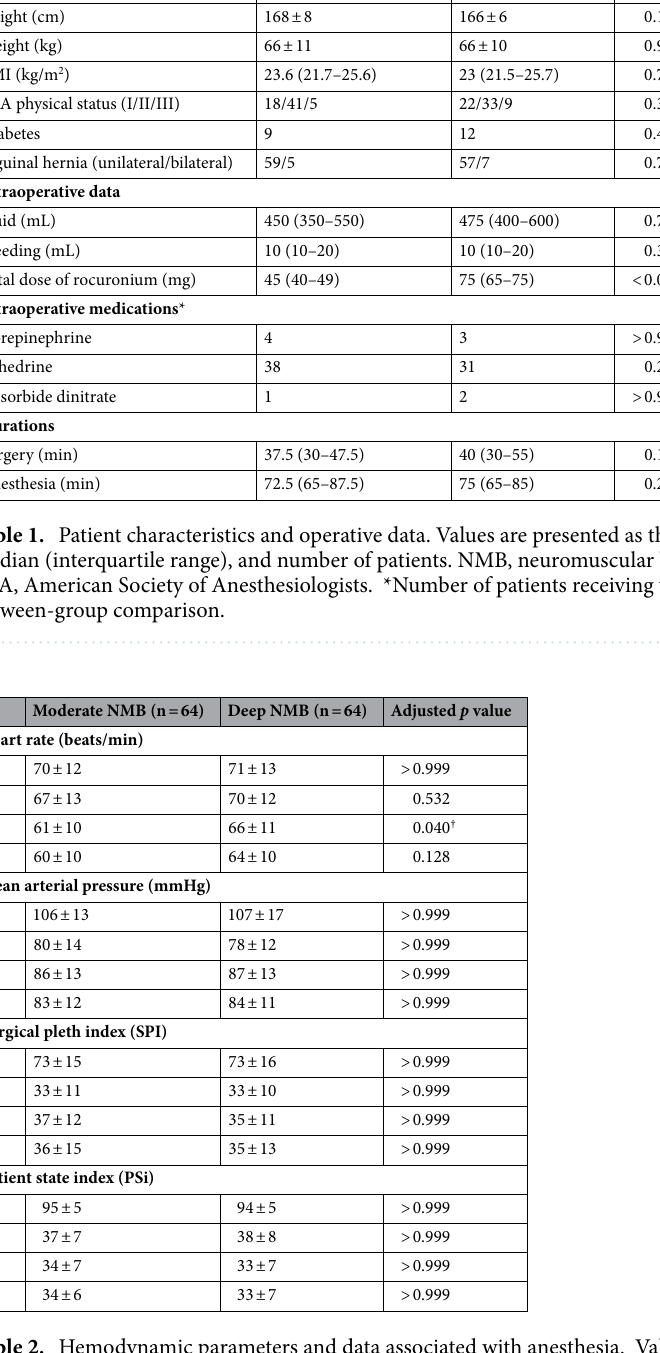
Table 2. Hemodynamic parameters and data associated with anesthesia. Values are presented as the mean ± standard deviation. NMB, neuromuscular block. T0, before induction; T1, 10 min after induction; T2, 20 min after CO 2 insertion; T3, the removal of laparoscopy. † p value < 0.05 between-group comparison.